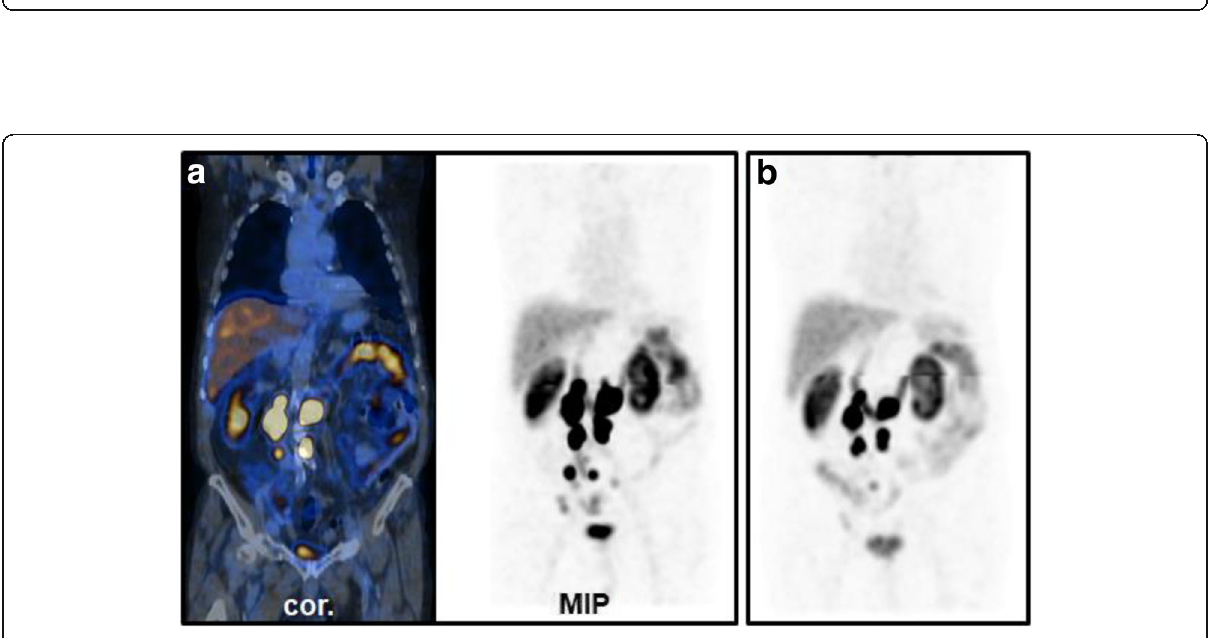
Fig. 4 [ 99m Tc]Tc-PSMA-I&S-SPECT/CT in primary high risk PCa. a 71-year-old man with Gleason 9 PCa (PSA 46 ng/ml). Apart from the primary tumor (green arrow), increased PSMA expression was detected in one lymph node in the right iliac region and in the left inguinal region (red arrows)(TxN1M0). b 77-year-old man with Gleason 9 PCa (PSA 80 ng/ml). PSMA expression was increased in the primary tumor only (green arrow), no metastases were detected (TxN0M0)